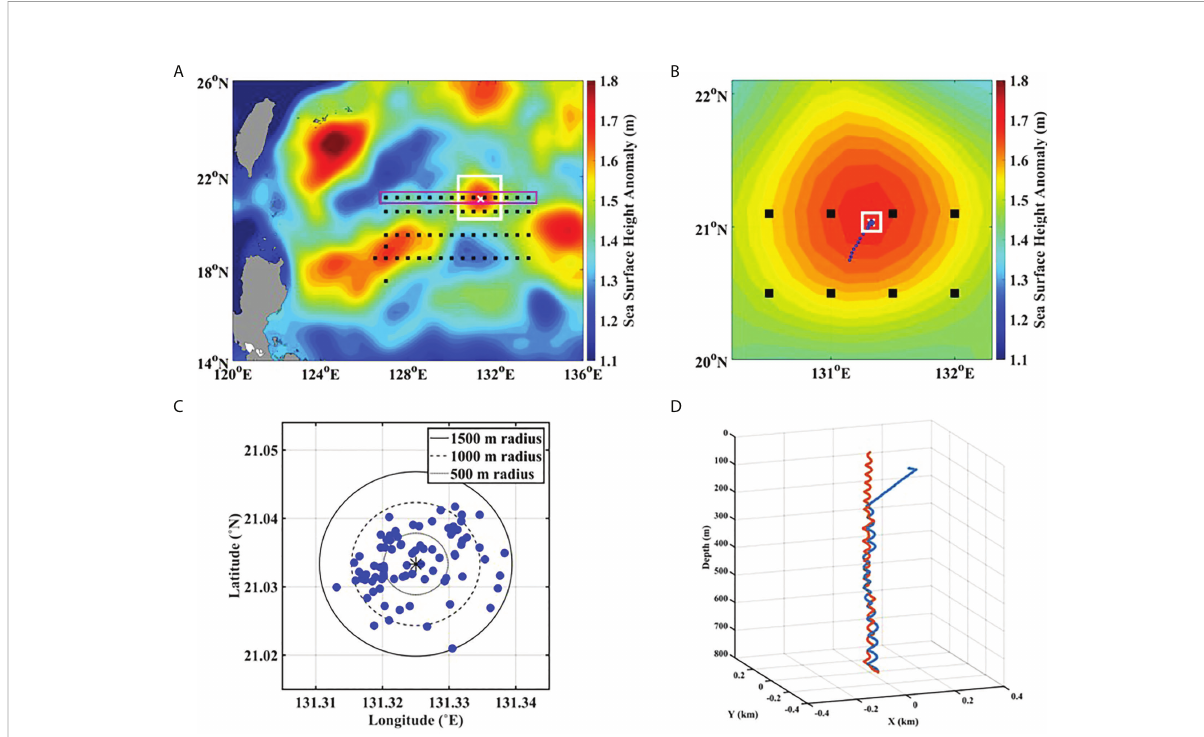
FIGURE 1 (A) Map of sea surface height (SSH) over the northwestern Paci fi c, including target spot (white cross in the white box), surrounded by warm and cold eddies of variable scale. The black dots indicate the path of R/V ISABU along which the conductivity – temperature – depth (CTD) pro fi les are obtained. Note that the eddy is approximately 1,000 km from the energetic region, Luzon Strait. (B) The white box of (A) is enlarged, where the SSH was obtained on September 11. A glider has moved to the eddy center along the path indicated by the blue dots. (C) The white box of (B) is enlarged. A glider was well controlled to surface within 720 m RMS around the waypoint, resulting in a dependable virtual mooring mode. (D) The underwater trajectory during a single dive of the Slocum glider attempting to hold the station at the target spot; dive (blue line) and climb (red line). Spiraling motion with a small radius is well maintained, except for the subsurface dive due to drift by the surface